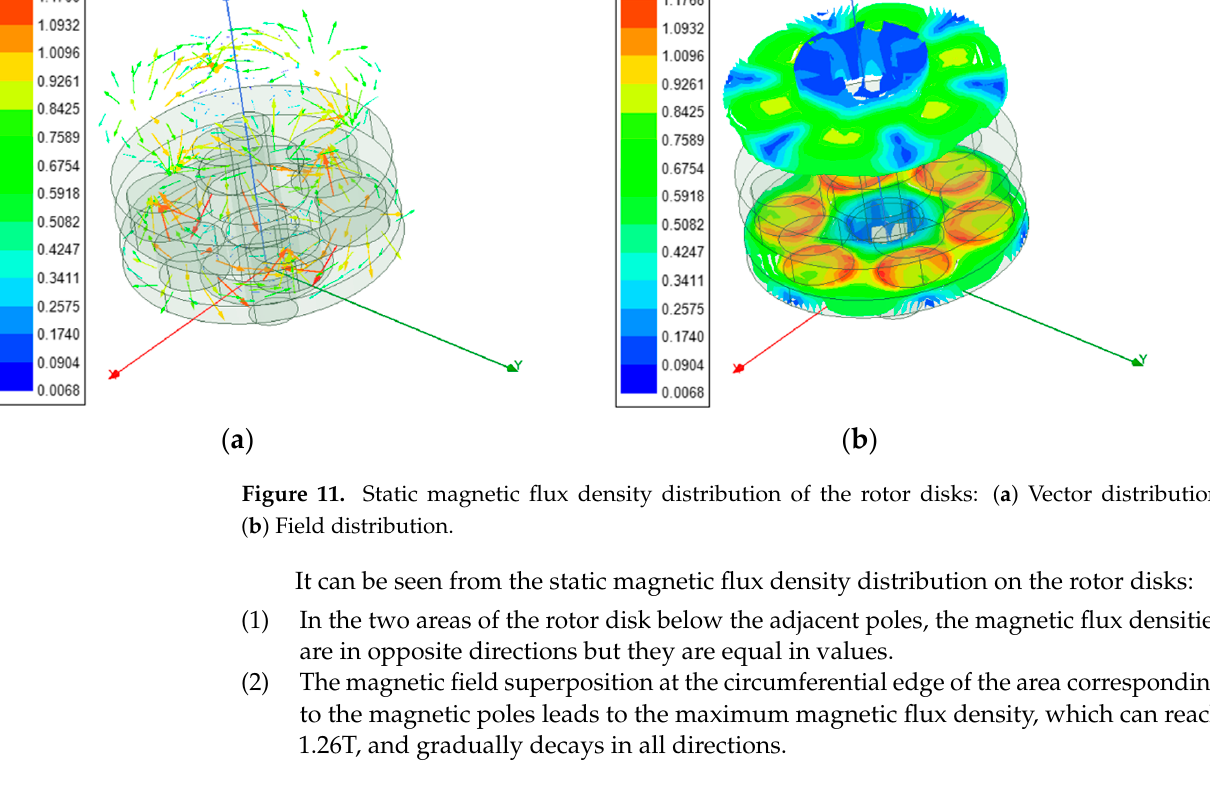
Figure 10. Magnetic flux density distribution of permanent magnet poles(static).